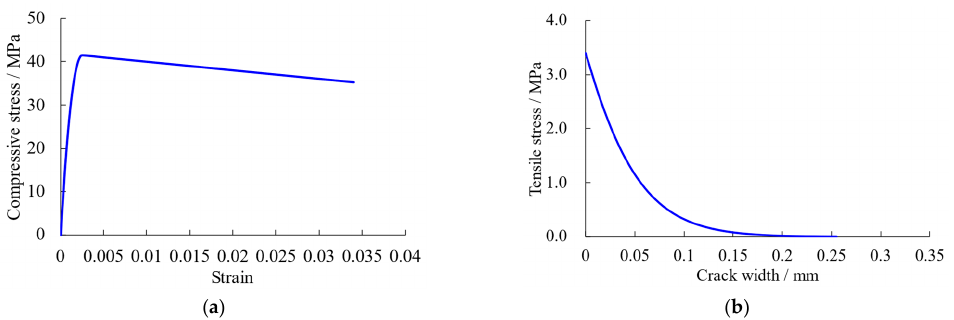
and constant items c 1 = 3, c 2 = 6.93.